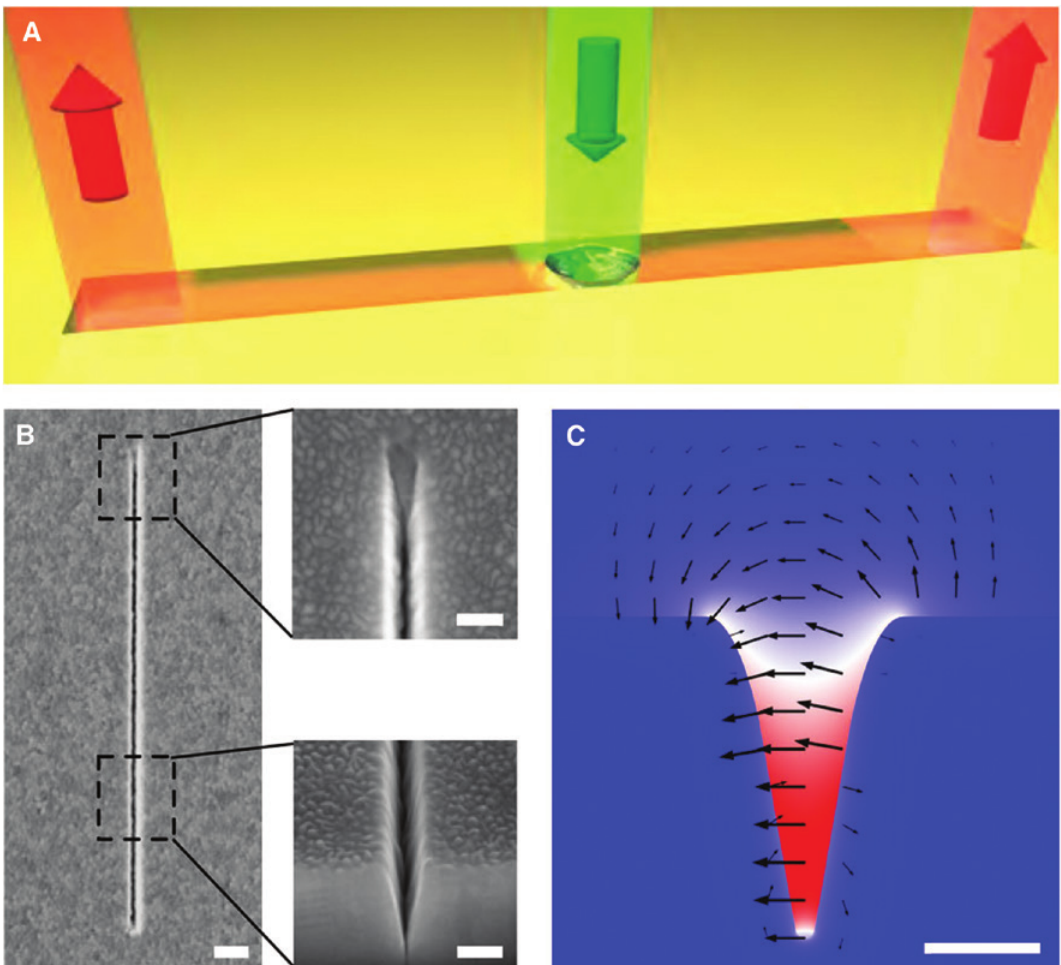
Figure 6: (A) Illustration of the approach for NV center channel plasmon coupling: a green laser excites the NV center, which decays by exciting channel plasmons along the V-groove and subsequently scatter to the far field at the ends. (B) Scanning electron microscope image of a V-groove fabricated in gold, illustrating the groove profile and a mirrors. (C) Total electric field profile of the supported channel plasmon mode. The field polarization is indicated by an arrow. Images taken from Ref. [56].